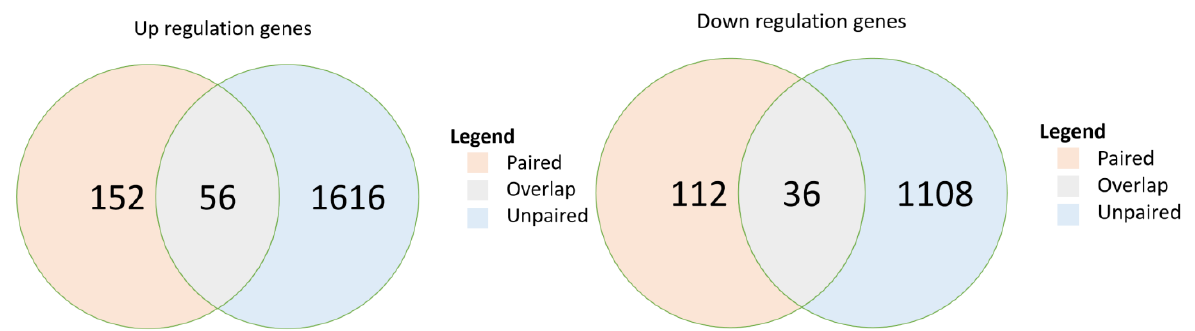
Figure 2. Overlap of differentially expressed genes in two breast cancer cohorts: paired sample cohort and unpaired sample cohort. p -values are calculated from hypergeometric distribution; pathways were selected if p < 0.05. DE, differentially expressed. Table 4. Pathway analysis of upregulated genes in paired and unpaired sample cohorts.*